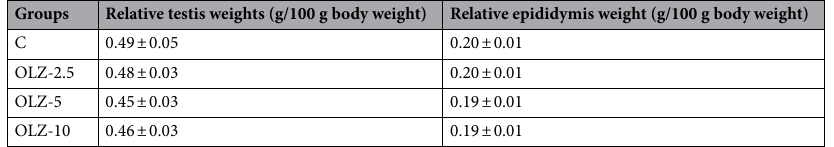
Table 1. Relative testis and epididymis weights among groups. Definition of abbreviations: OLZ-2.5 2.5 mg kg −1 olanzapine-administered rats for 28 days group, OLZ-5 5 mg kg −1 olanzapine-administered rats for 28 days group, OLZ-10 10 mg kg −1 olanzapine-administered rats for 28 days group. Results were given as mean ± standard error.